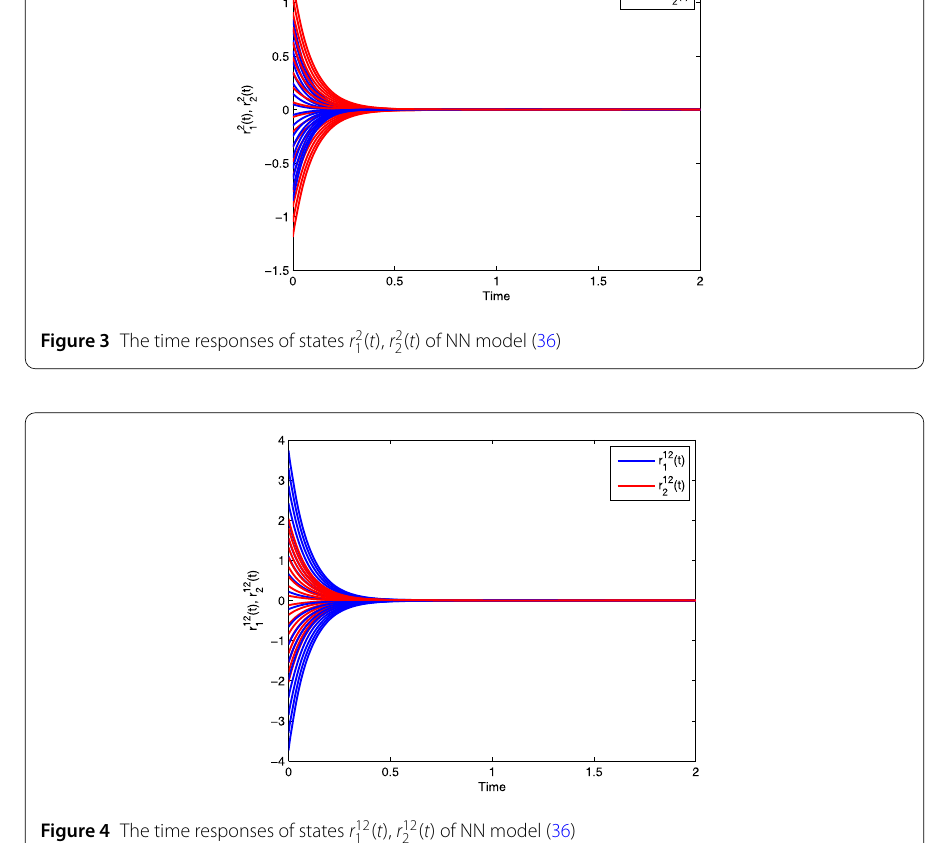
Figure 4 The time responses of states r 12 1 ( t ), r 12 2 ( t ) of NN model